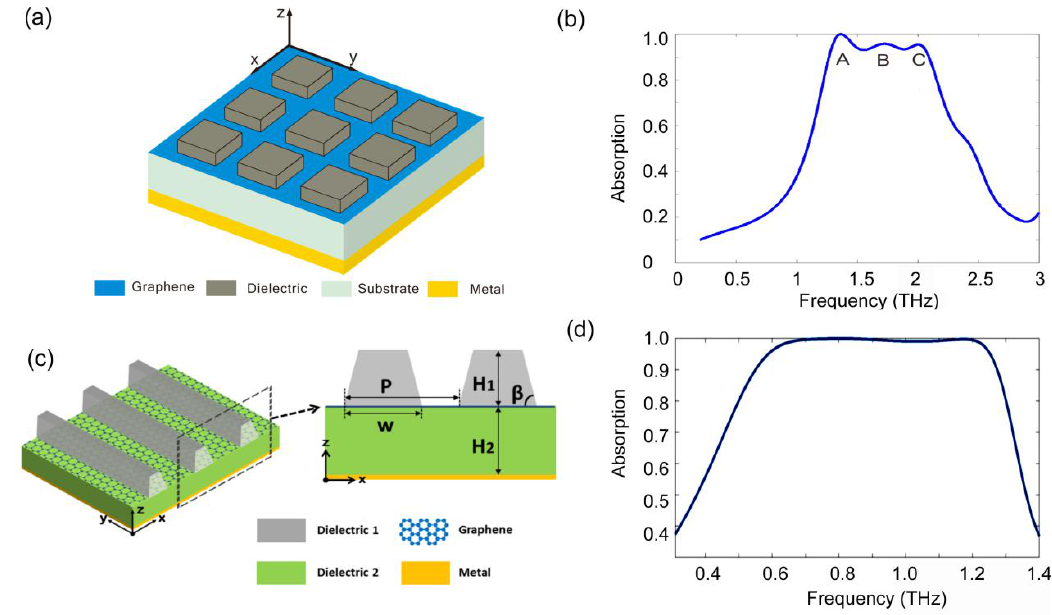
Figure 4. ( a ) Schematic depiction of the absorption structure by coupling unpatterned graphene with dielectric bricks. ( b ) Calculated absorption spectrum of the designed structure shown in ( a ) under normal incidence [118]. ( c ) Schematic illustration of the absorption structure by coupling unpatterned graphene with dielectric wires. ( d ) Calculated absorption spectrum of the designed structure shown in ( c ) for TM polarization under normal incidence [24]. Reproduced from references [24,118], with permission from Optical Society of America, 2018; with permission from Optical Society of America,